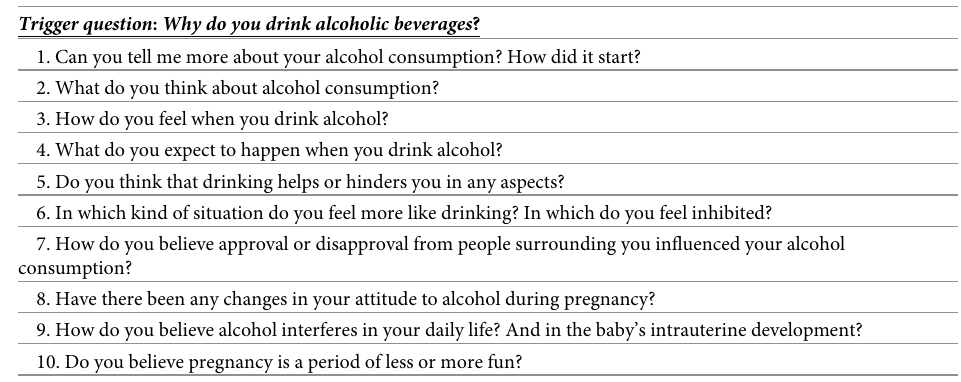
Table 2. Semi-structured script used in individual interviews. Trigger question : Why do you drink alcoholic beverages